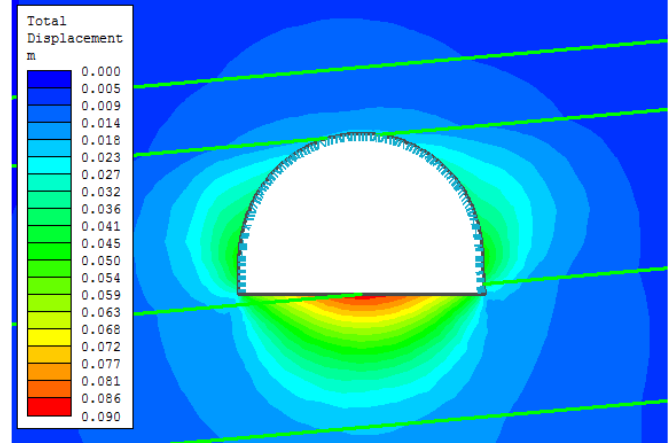
Figure 8. Results of numerical modeling of rock deformation around roadway D-2 for elasto-plastic rock mass with reinforcement.